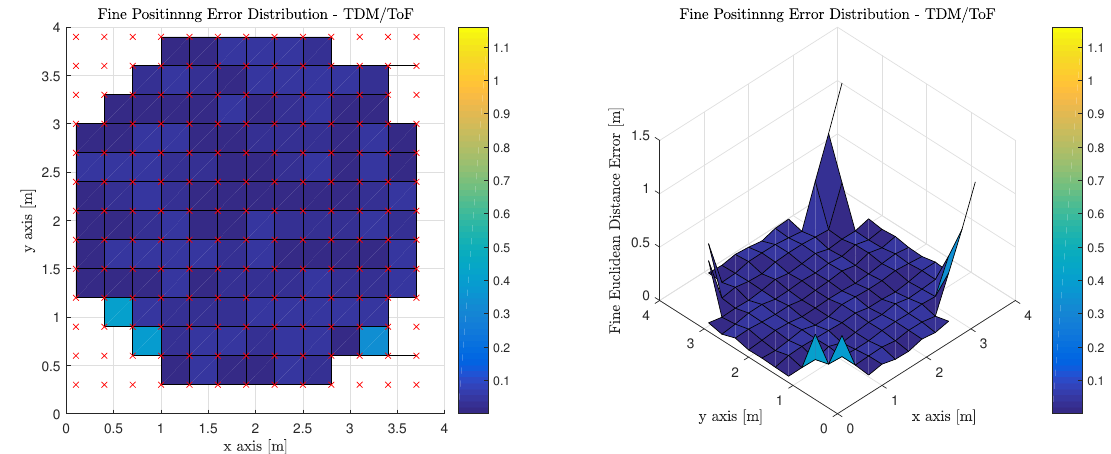
Figure 14. Fine Phase Positioning Performance in Candidate Room using Time of Flight Measurement, Geometric Constrained Optimized Triangulation Positioning Algorithm and Time Division